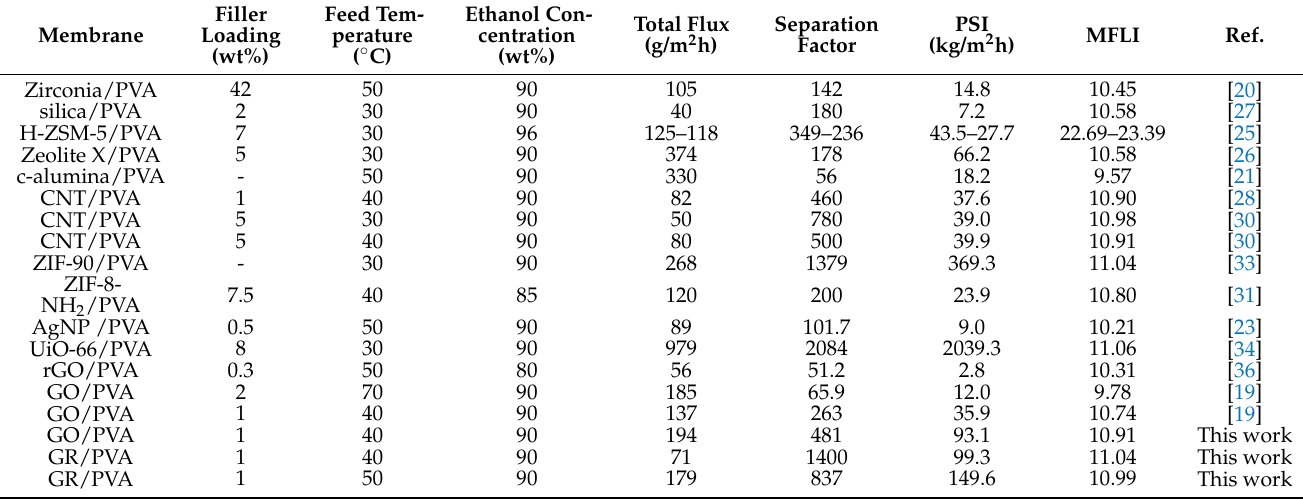
Table 2. PV performance of PVA-based MMMs for ethanol